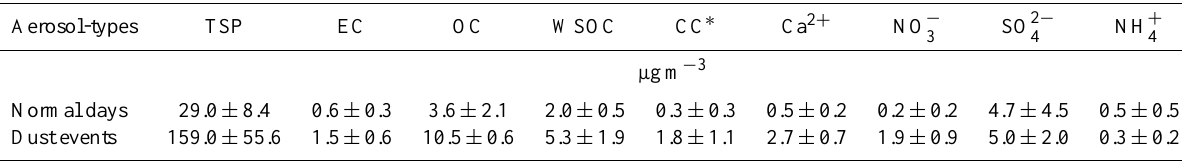
Table 3. The chemical composition and optical parameters in ambient aerosols at Manora Peak during normal days and Dust events in the premonsoon season (April–June).